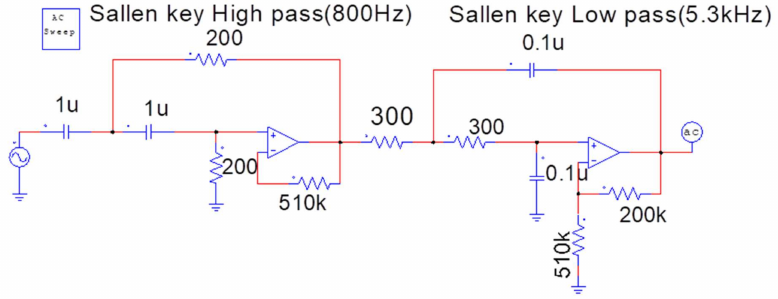
Figure 15. Active filter circuit for the